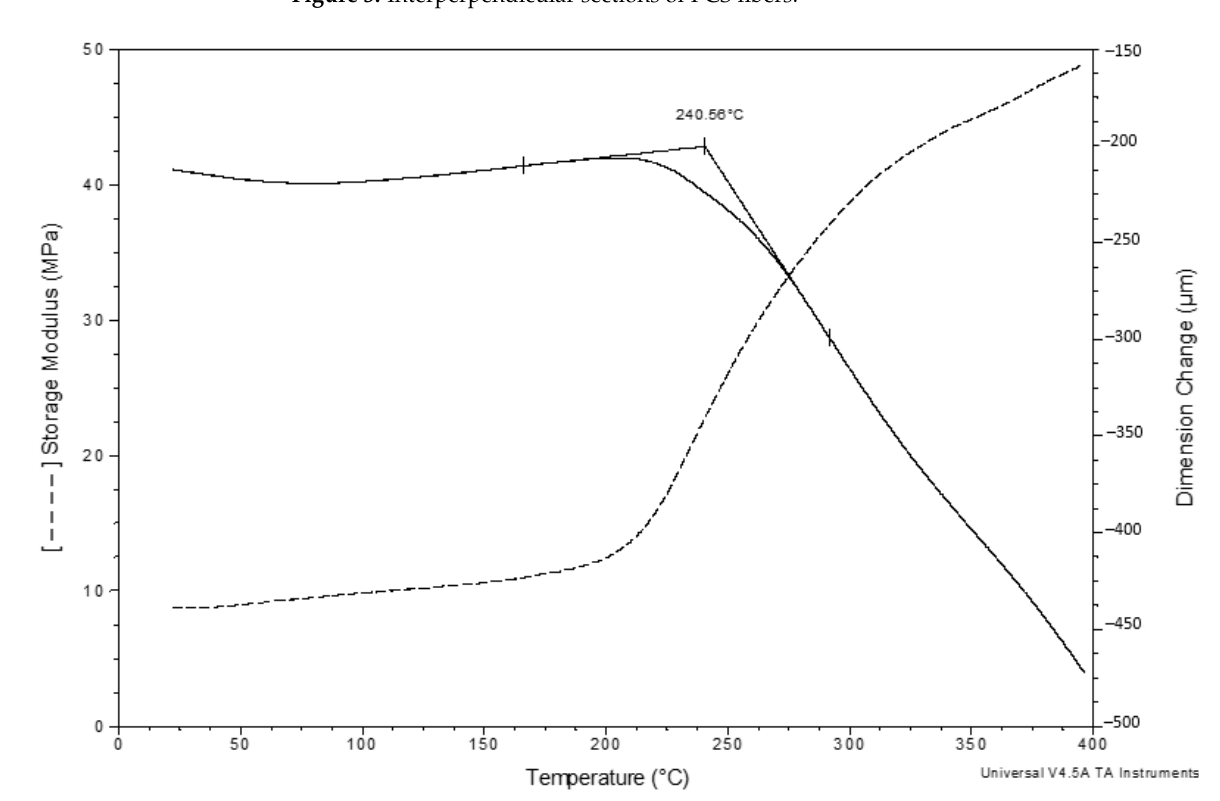
Figure 4. Elasticity modulus vs. temperature curves obtained for the PCS fiber bundle.